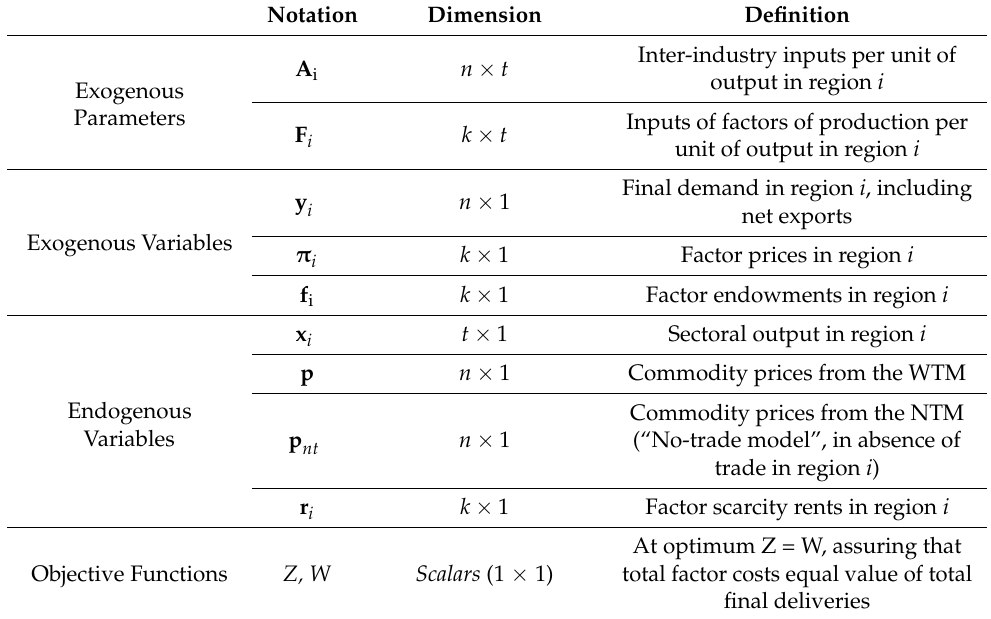
Table 1. Model parameters and variables ( m regions, n sectors, t technologies (in the original WTM t = n , while potentially different in the rectangular choice of technology (RCOT)) and k factors of